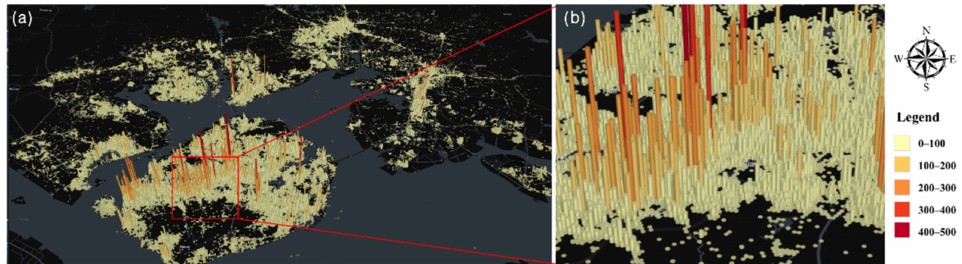
Figure 7. Grid-based POI numbers: ( a ) POIs in the 3D display; and ( b ) zoomed-in area of the red